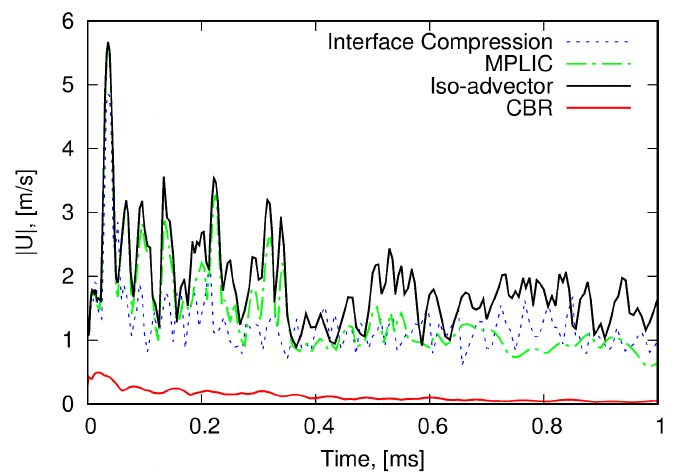
Figure 3. The strength of the spurious current for various VoF reconstruction methods in